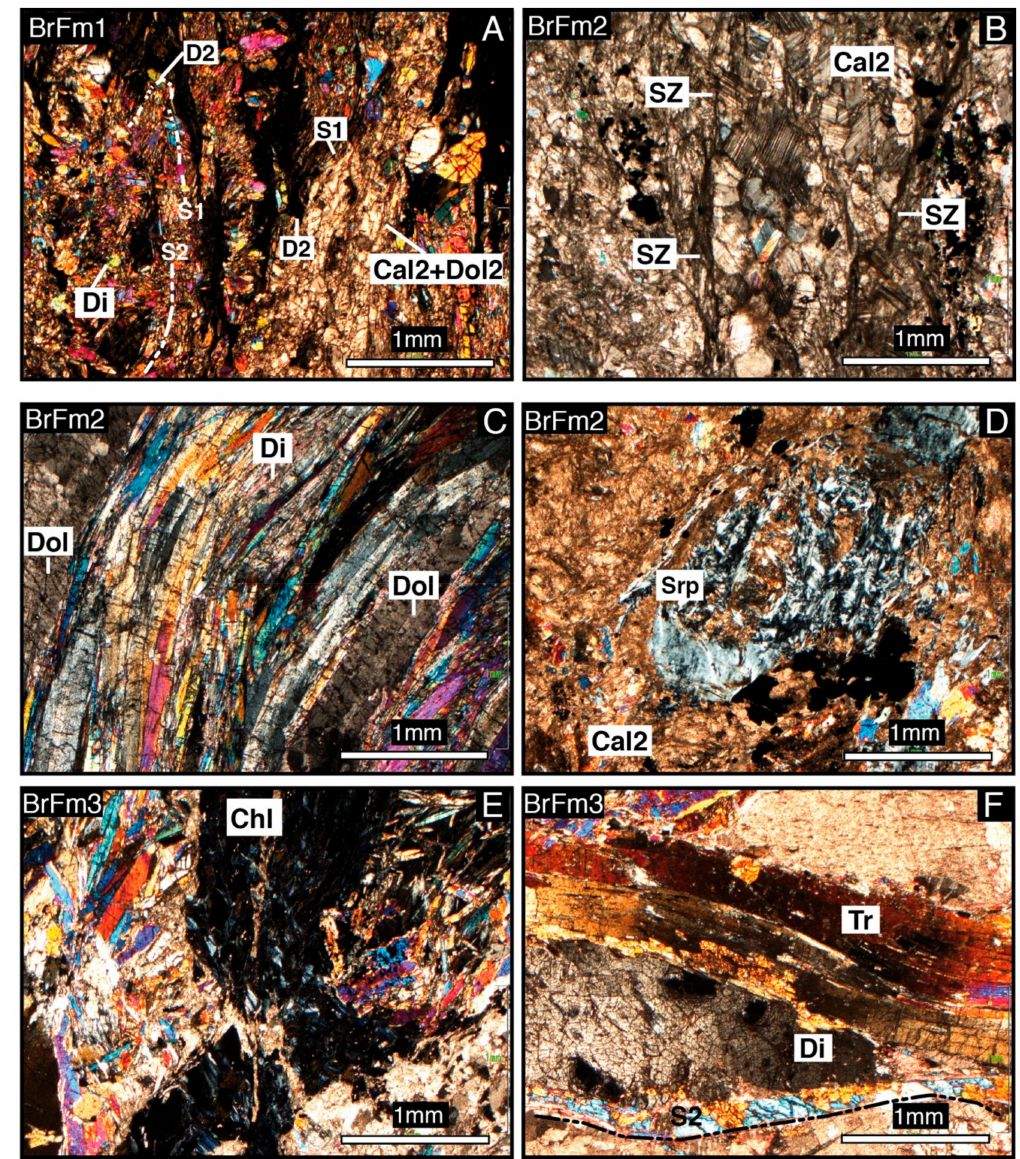
Figure 9. Photomicrographs illustrating the main microstructural features of BrFm1, BrFm2, and BrFm3. All pictures are taken under crossed nicols. Mineral abbreviations after [104]. ( A ) Highly transposed mafic / ultramafic domains and Cb-rich domains in BrFm1 sample. Relict D 2 fold hinges (D 2 ) are still recognizable. Relict S 1 corresponds to the contact between the two domains. ( B ) Sub-millimeter anastomosing shear zones (SZ) developed in carbonate-rich matrix mainly composed of Cal2 grains. ( C ) lose-up view of minerals filling the boudin neck between ultramafic boudins in BrFm2 (see Figure 7C for outcrop view); Dol and Di crystals are stretched and slightly curved. In the picture the main (S 2 ) foliation is sub-parallel to crystals. ( D ) Fragment of Srp embedded in Cb-rich matrix in BrFm2 (see text). ( E ) Detail of BrFm3 matrix: elongated or folded layers made of Chl + Opq probably deriving from ultramafic clasts embedded within a carbonate + amphibole-rich matrix. ( F ) Intrafoliar vein in BrFm3. The vein is composed of Amp (Tr), Ep, Cal2 / 3, and Cpx (Di), this latter forming lenticular aggregates parallel to the S2 foliation